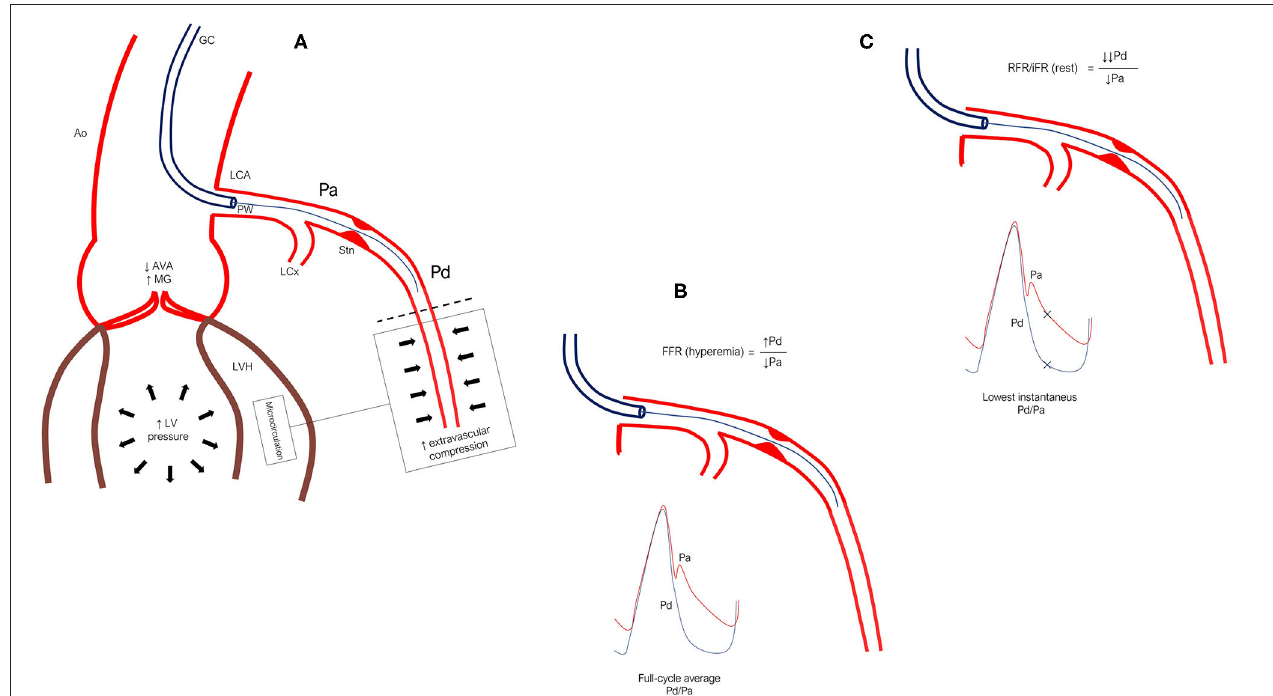
FIGURE 1 | (A) In severe aortic stenosis, systemic, and thus aortic pressure, Pa, is often reduced due to pressure loss across the aortic valve. Meanwhile, elevated LV pressure and increased contraction force due to LVH causes intramyocardial compression of the microcirculation, driving up mean distal coronary pressure, Pd (back-pressure). (B) FFR is measured as the ratio of full-cycle mean Pd/Pa during maximal hyperemia. As such, flow rate and subsequent pressure loss across the epicardial stenosis would not be expected to vary much before vs. after TAVI. However, relief from extravascular compression (LVH and high LV pressure especially during systole) after TAVI may cause Pd to fall, thus lowering FFR. (C) The major difference between FFR and iFR/RFR is that the latter are measured during rest and are calculated as the lowest instantaneous Pd/Pa, which typically occurs during diastole. This is a potential source of error in severe AS because resting flow rate is elevated due to increased myocardial workload. Therefore, when pressure is sampled only in diastole—where pressure separation is very large in AS patients—the calculated Pd/Pa can turn out to be lower than that calculated from the full-cycle averages of Pd/Pa even during maximal hyperemia (i.e., FFR). As pressure loss across a stenosis is closely related to flow rate, measuring IFR/RFR before TAVI likely overestimates the significance of a stenosis as compared with evaluation after TAVI where resting flow and subsequent pressure loss are drastically reduced. Ao, indicates aorta; AVA, aortic valve area; FFR, fractional flow reserve; GC, guide catheter; iFR, instantaneous wave-free ratio; LCA, left coronary artery; LCx, left circumflex artery; LV, left ventricle; LVH, left ventricular hypertrophy; MG, mean gradient; Pa, aortic pressure; Pd, distal coronary pressure; PW, pressure wire; RFR, resting full cycle ratio; Stn,